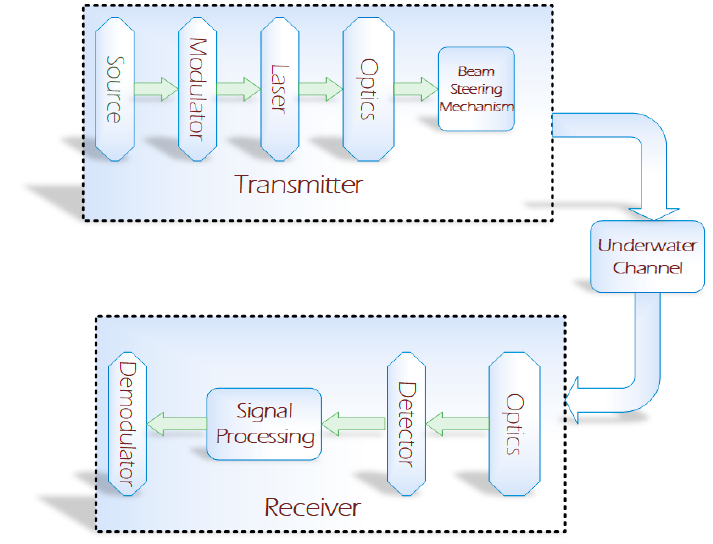
Figure 1. Block diagram of underwater optical communication.